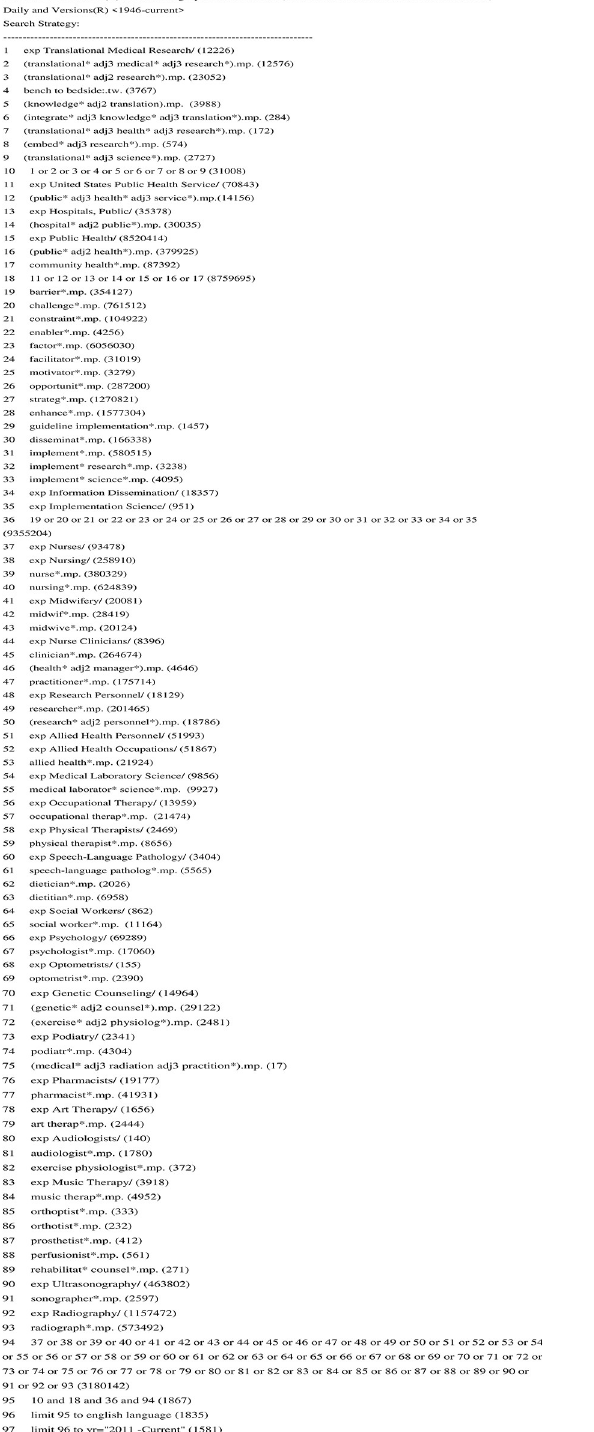
Fig 2. Search strategy example in